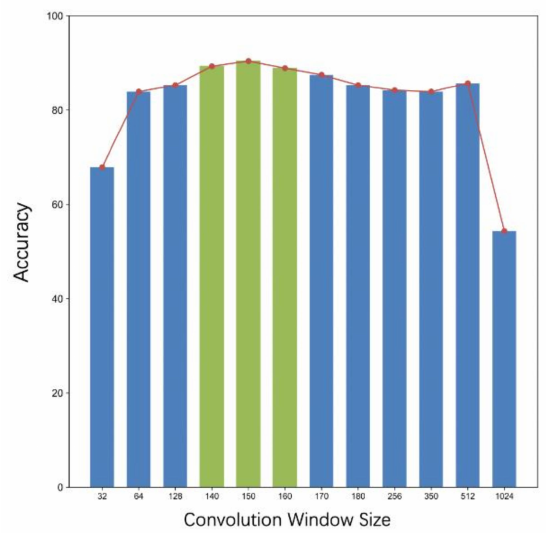
Figure 8. Convolution window size